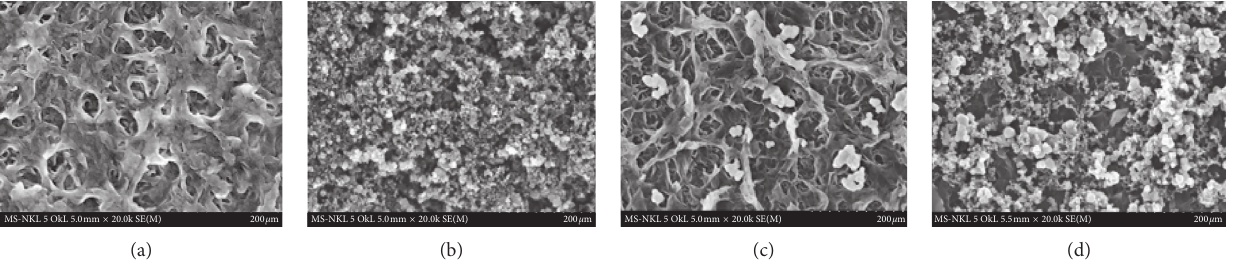
Figure 3: SEM images of (a) PA, (b) PA/GO, (c) PA/TiO